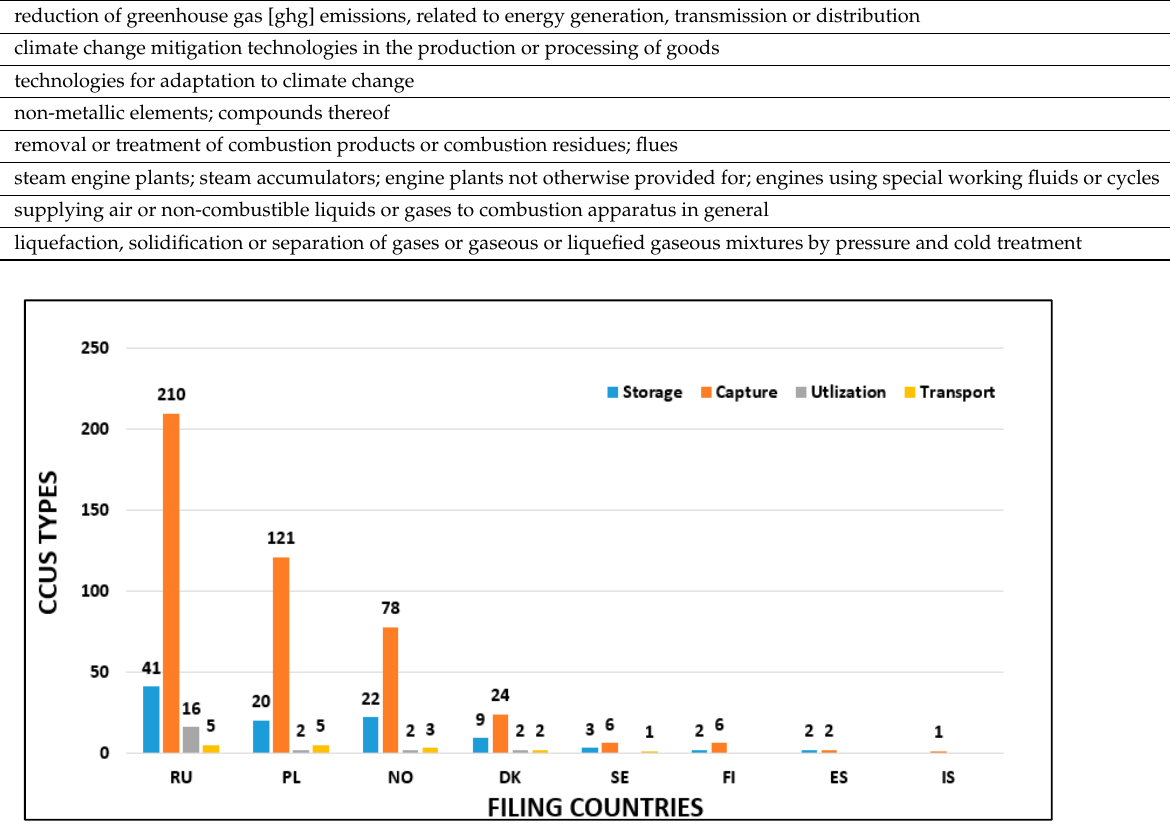
Figure 11. CCUS types—countries (Level 1 category).